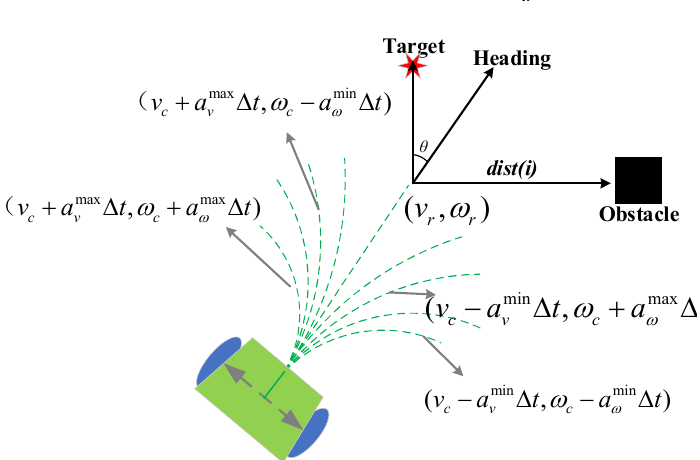
Figure 5. Schematic diagram of robot velocity constraints.